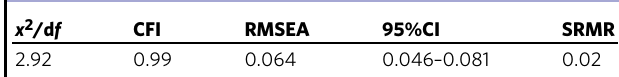
Table 2 SHLS-106 incremental variance in marital satisfaction of 421 married students.